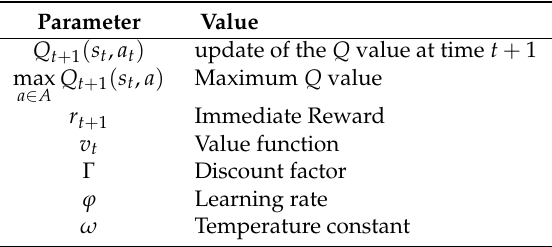
Table 2. Reinforcement learning